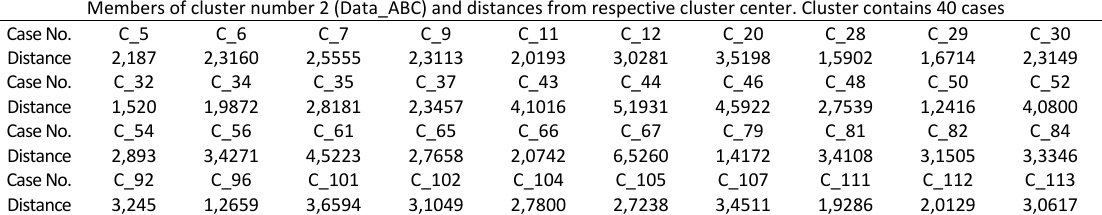
Table 4: The structure of category B group offices of KNUTD academic building B4 (STATISTICA 10 listing) Members of cluster number 2 (Data_АВС) and distances from respective cluster center. Cluster contains 40 cases Case No.